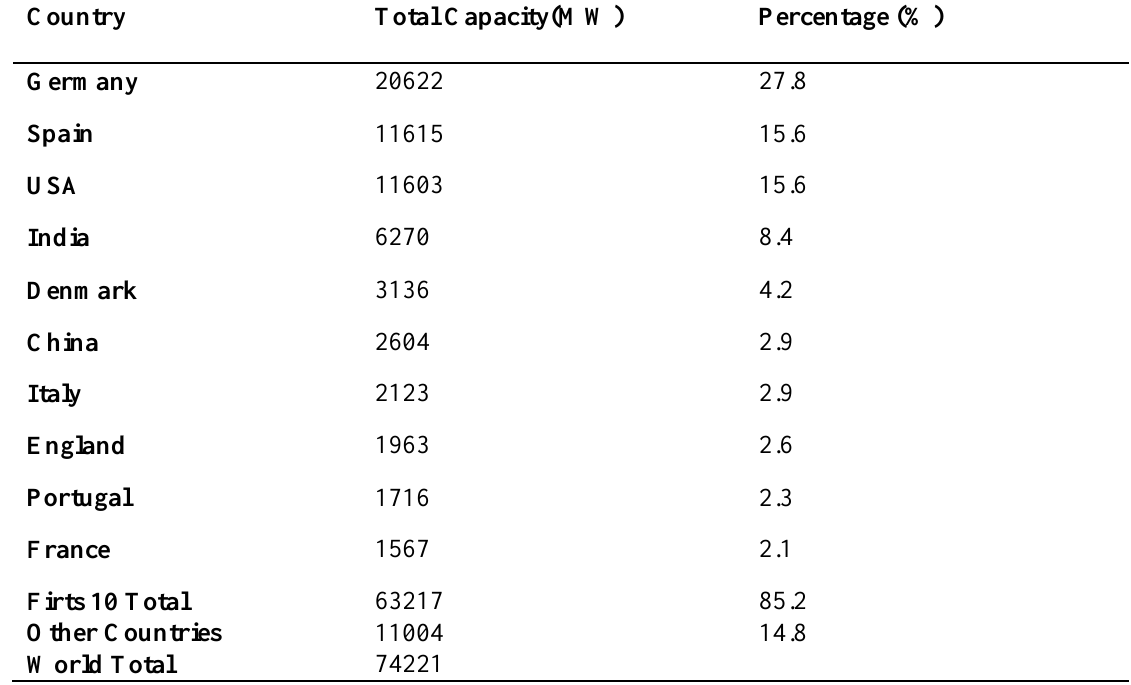
Table 1. Distribution of installed wind energy in the world by